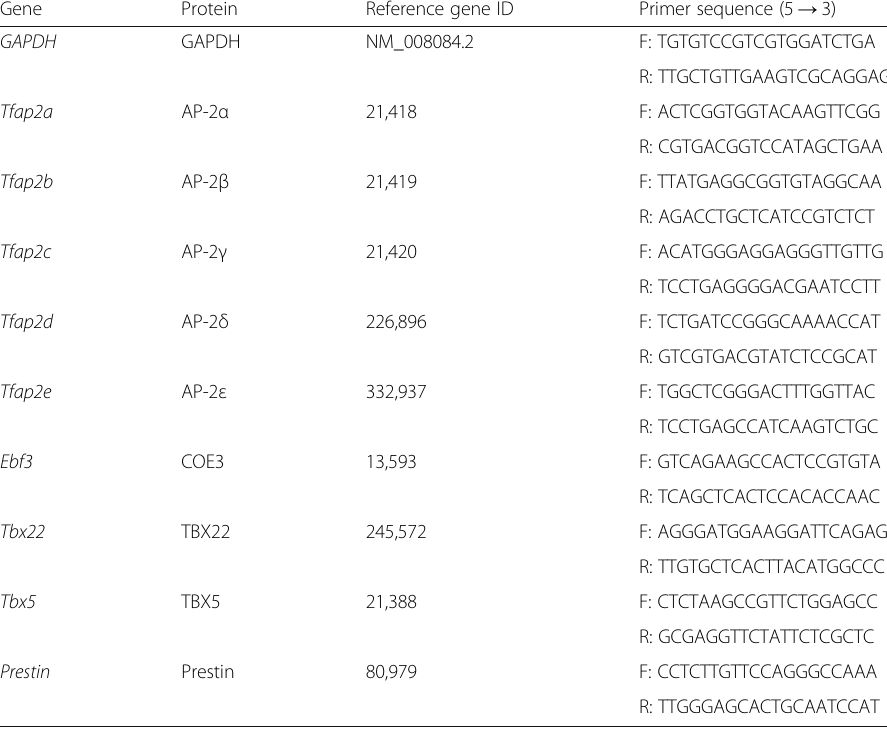
Table 1 Primer sequences for qRT-PCR of target genes (F forward, R reverse, bp base pair) Gene Protein Reference gene ID Primer sequence (5 →